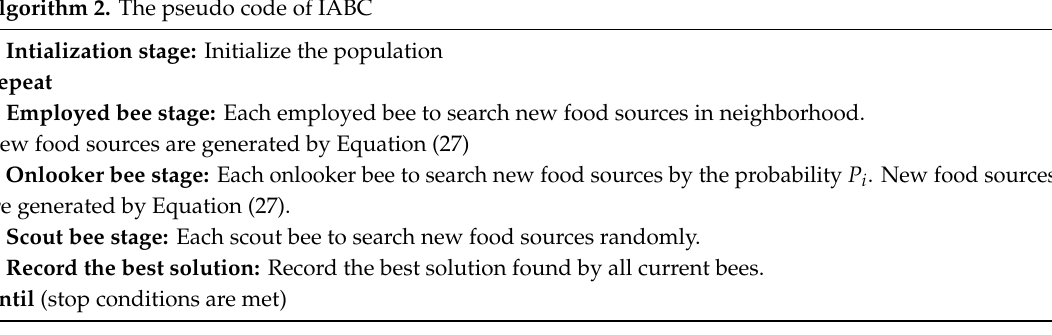
Figure 3. The relationship between b , α and the number of iterations. Algorithm 2. The pseudo code of